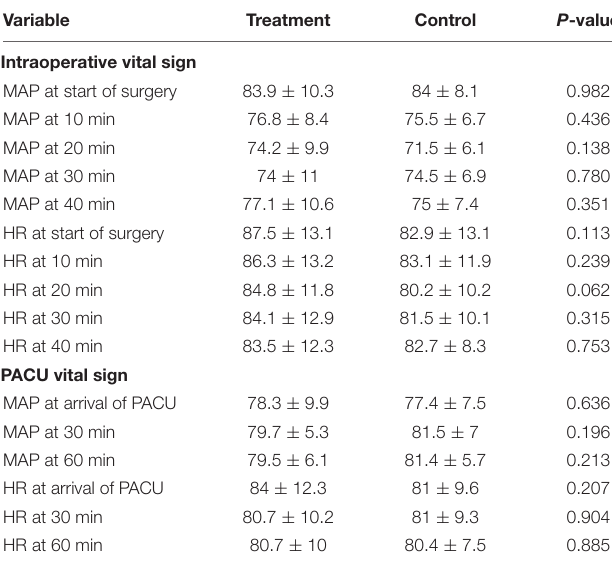
TABLE 2 | Intraoperative and post anesthesia care unit (PACU) vital sign of pregnant women undergoing C/S under spinal anesthesia (SA) in Dilla University Referral Hospital,